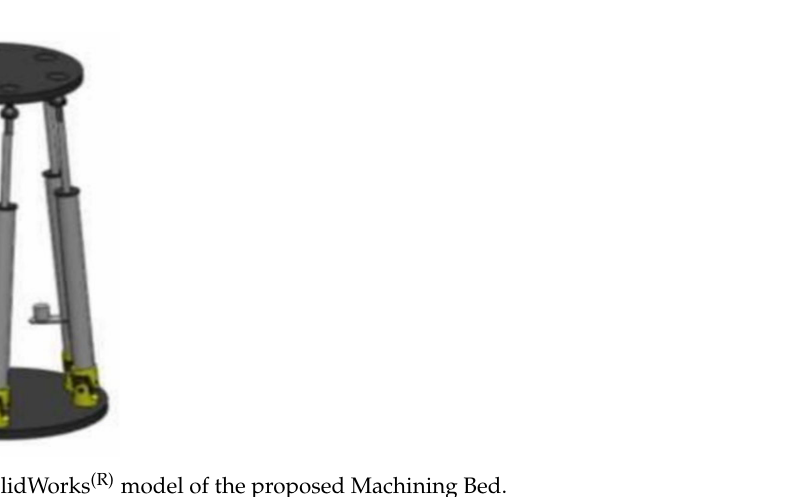
Figure 2. SolidWorks (R) model of the proposed Machining Bed. Table 1. Literature review of various configurations of six degrees of freedom parallel manipulators. Sr. No.